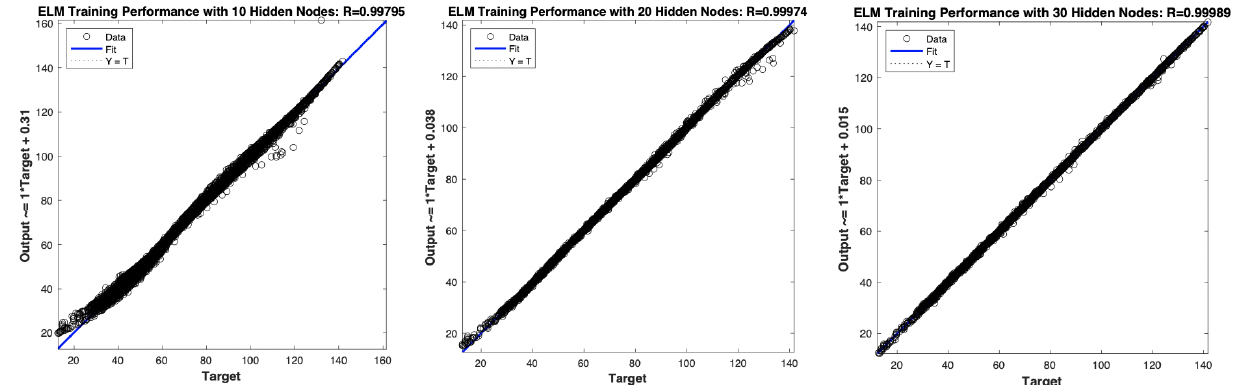
Figure 2. Regression plots of the individual model for the WT#80 in the training step as the size of the network increases ( H = 10, 20 and 30).